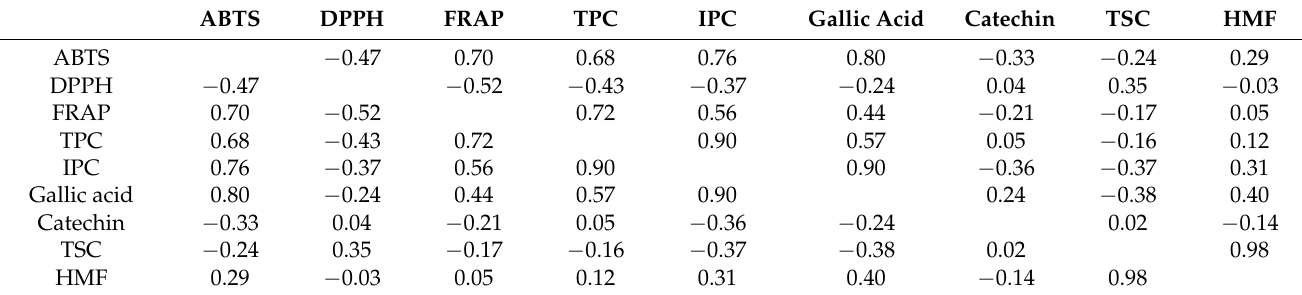
Table 3. Correlation coefficients between phenolic compounds and antioxidant